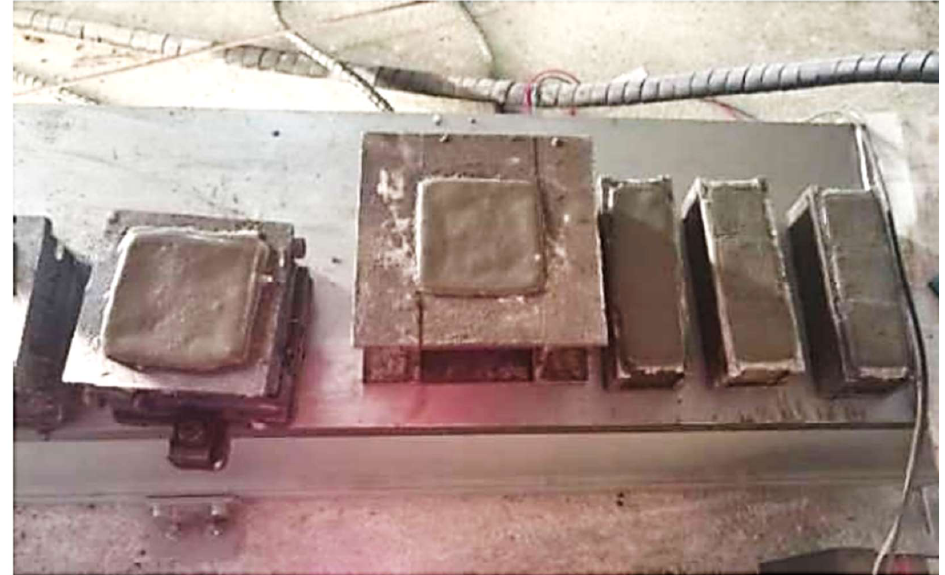
Figure 3. Molded Concrete Specimens.